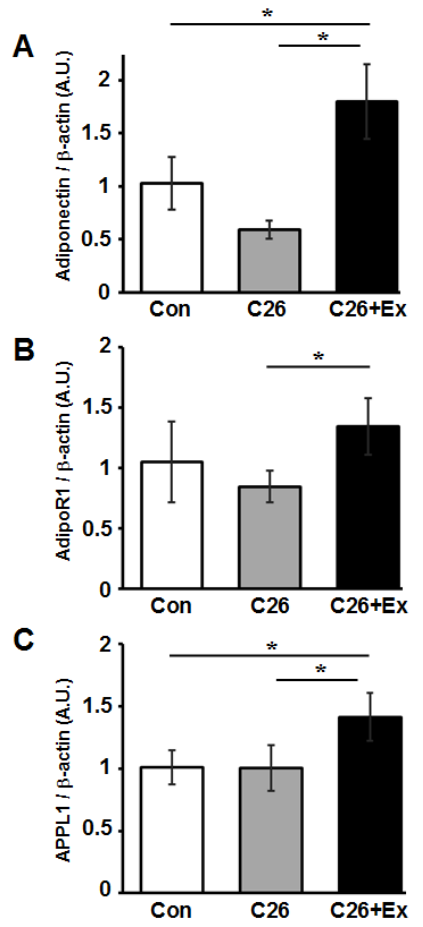
Figure 4. Increased expression of adiponectin and its related genes caused by forced aerobic exercise. Expression of ( A ) adiponectin, ( B ) AdipoR1, and ( C ) APPL1 in TA of Con, C26, and C26+Ex mice was examined by quantitative real-time PCR. The bar graphs indicate the mean relative expression ± SD. Statistical analysis was carried out with ANOVA followed by Tukey HSD tests. *: p < 0.05.